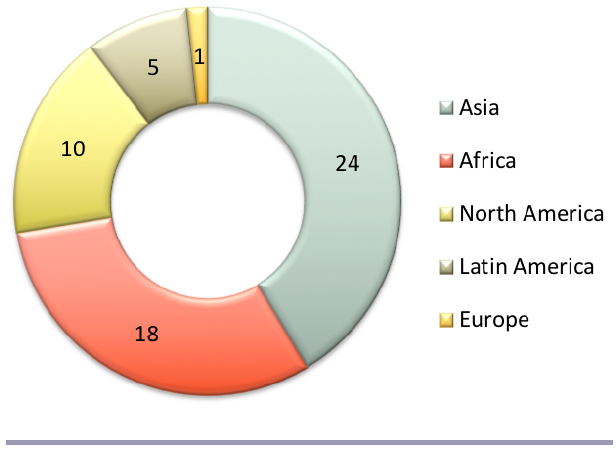
Fig. 1 . Geographic location of Fellows’ organizations at time of acceptance.